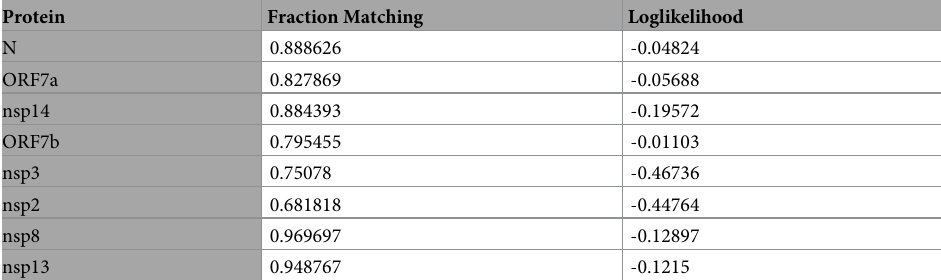
Table 1. Sequence homology of selected SARS and SARS-CoV-2 proteins. Protein Fraction Matching